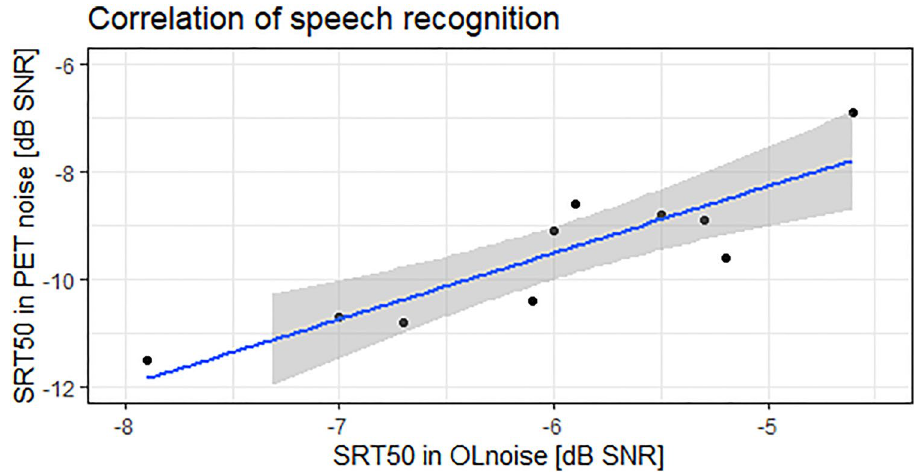
Figure 5. Scatter plot of 50% speech reception threshold (SRT50) obtained for sentences in background noise of the Oldenburg sentence test (OLnoise) or PET noise (Philipps Vereos PET/CT) at 76.9 dB SPL